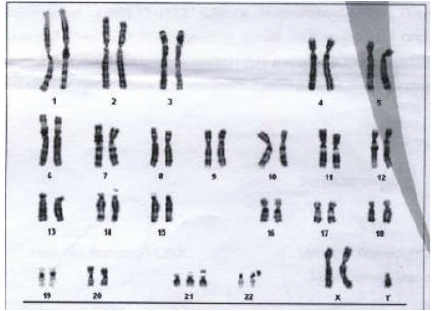
Figure 3: Karyotype of the fetus with